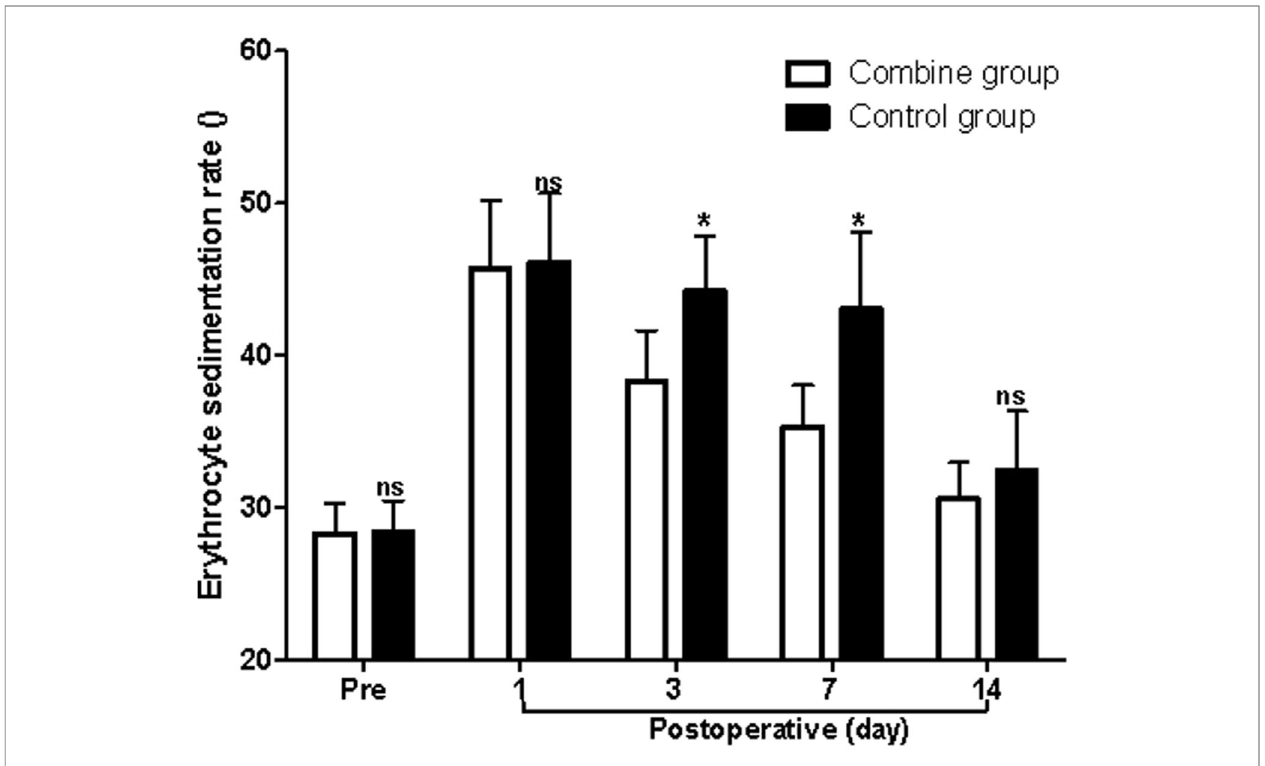
FIGURE 3 | Comparison of the erythrocyte sedimentation rate at different times in patients of two groups. Note: Compared with the combine group, ns p >0.05 and * p